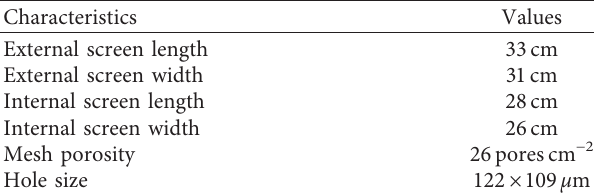
Table 1: Used coating screen